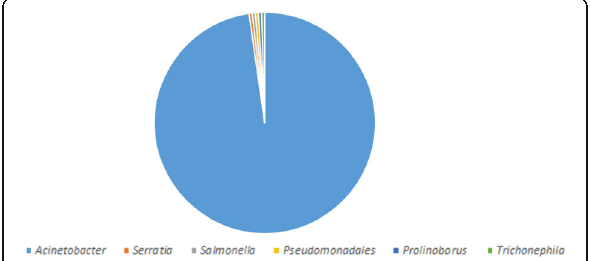
Fig. 10 Similarity pie diagram of MurG from A . baumannii and its related sequences from various genus obtained from